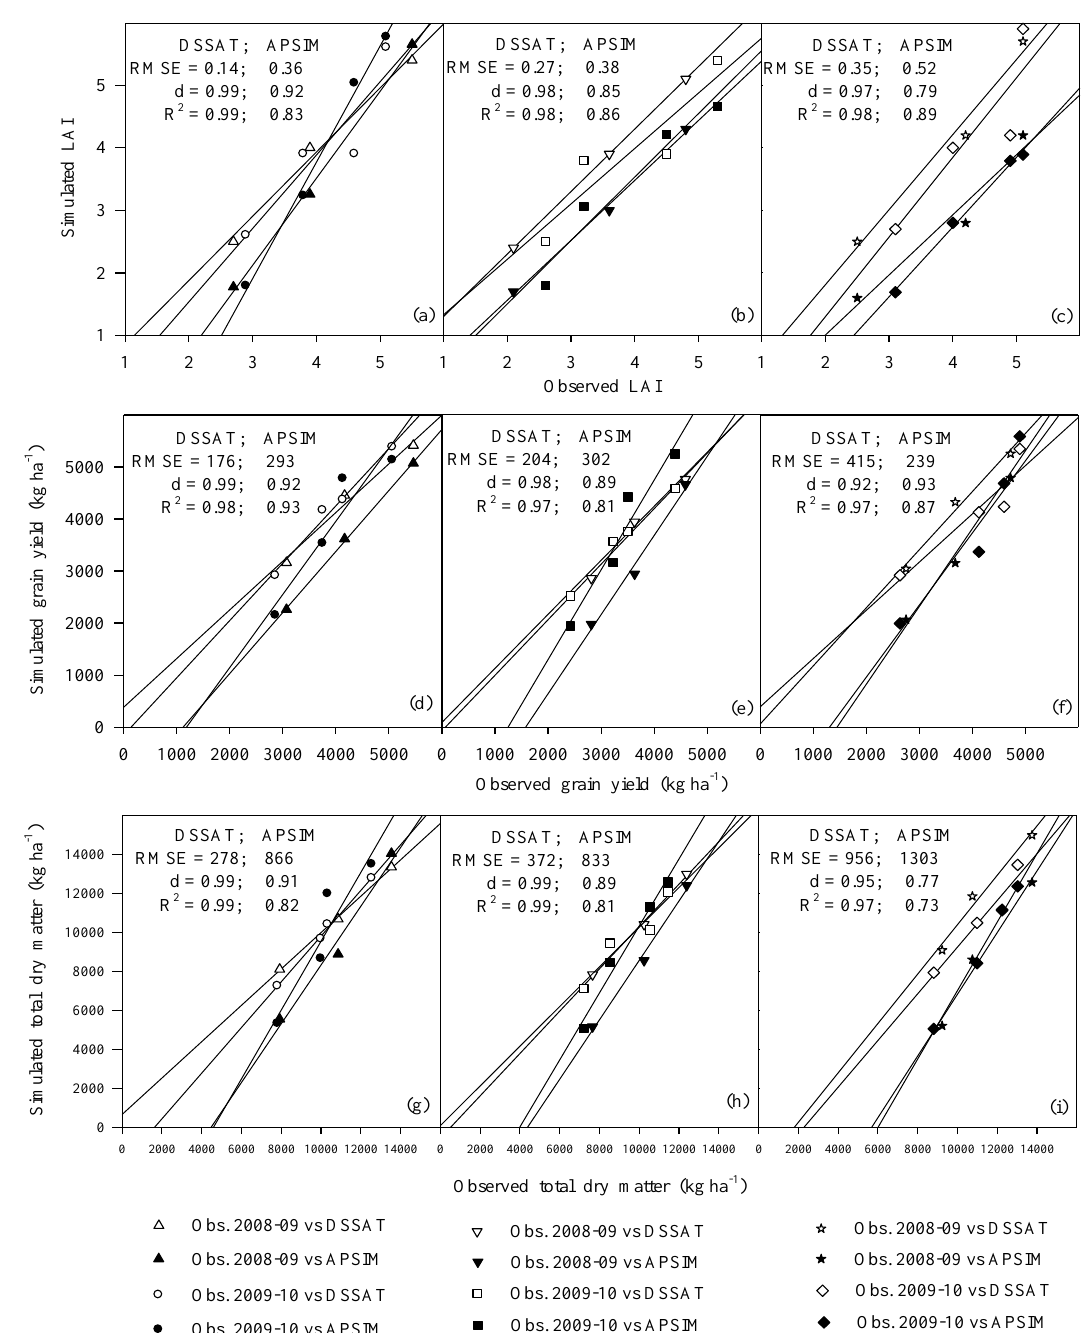
Figure 5. Comparison of measured and simulated LAI ( a – c ), grain yield ( d – f ) total dry matter ( g – i ) of wheat cultivars with different nitrogen application rates during the calibrated year 2008 – 2009 and evaluation year 2009 – 2010.